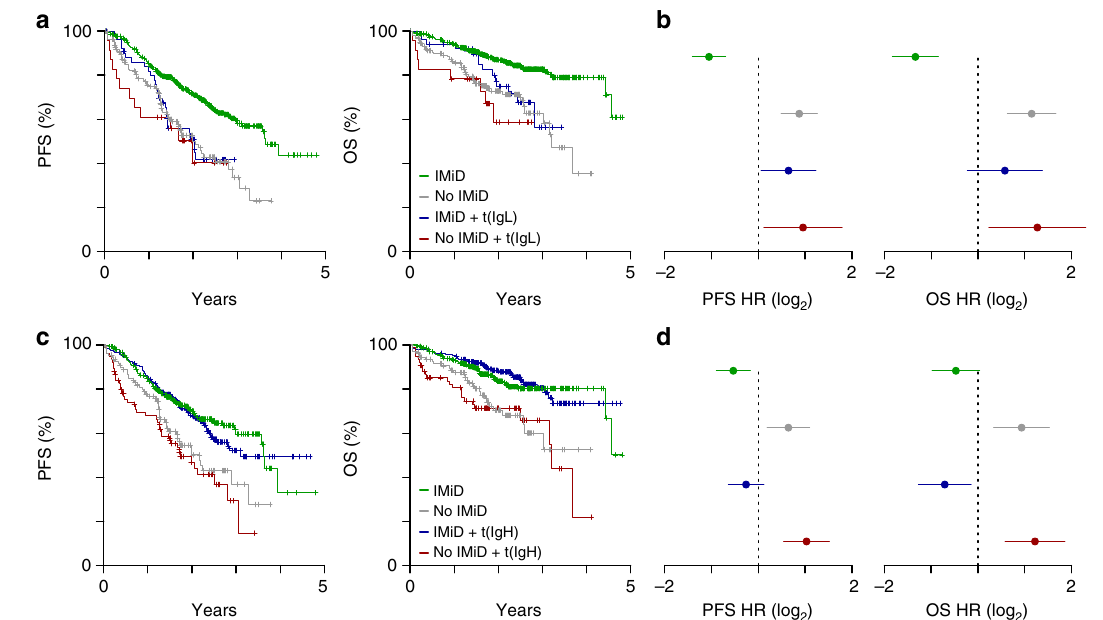
Fig. 7 IgL translocated myelomas do not bene fi t from IMiDs. a Progression-free (PFS; left) and overall survival (OS; right) Kaplan-Meier curves for non-t (IgL) patients with (green; N = 463) or without (gray; N = 164) front-line IMiD containing therapy (PFS P = 3.3 × 10 − 7 ; OS P = 1.1 × 10 − 6 ), as well as t(IgL) patients with (blue; N = 51) and without (red; N = 23) front-line IMiD therapy (PFS P = 0.51; OS P = 0.19). b PFS (left) and OS (right) hazard ratios (HR) for the populations de fi ned in part a . c PFS and OS as in part a except comparing non-t(IgH) patients with (green; N = 301) and without (gray; N = 111) front-line IMiD therapy (PFS P = 7.4 × 10 − 4 ; OS P = 1.7 × 10 − 3 ) as well as t(IgH) patients with (blue; N = 213) and without (red; N = 76) front-line